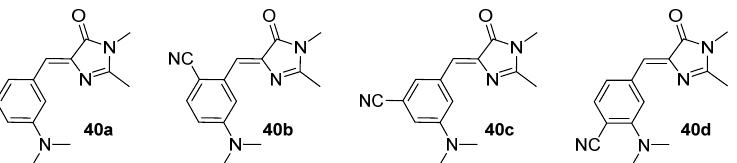
Figure 36. GFPc analogues structurally unconstrained presenting high quantum yields in solution [52].